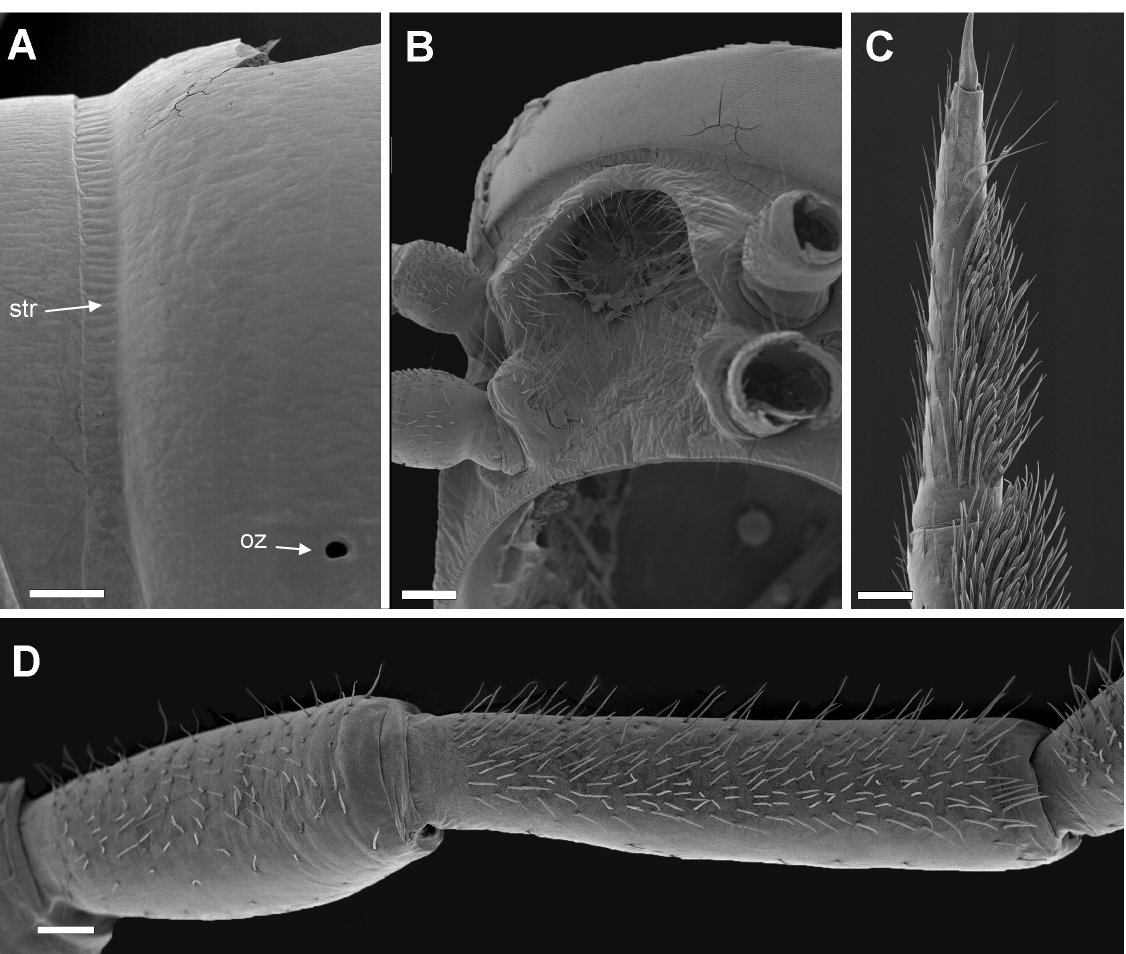
Fig. 30. Eviulisoma zebra sp. nov., paratype. A . Midbody ring, showing carinulate stricture and ozopore. B . Sternum 6, showing lobate rim of excavation. C–D . Midbody leg. C. Tarsus and part of tibia, showing scopulae. D. Prefemur and femur, showing dense setation. Abbreviations: oz = ozopore; str = stricture. Scale bars: A–B = 0.2 mm; C–D = 0.1